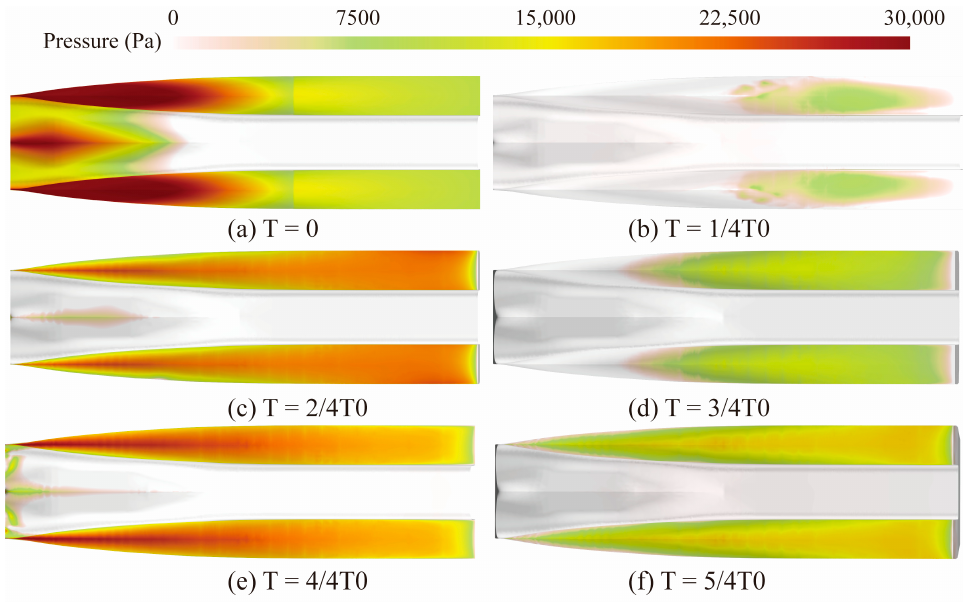
Figure 23. Pressure distribution at the bottom of the USV under 7 level sea state with the 0° wave direction (Positive pressure area).